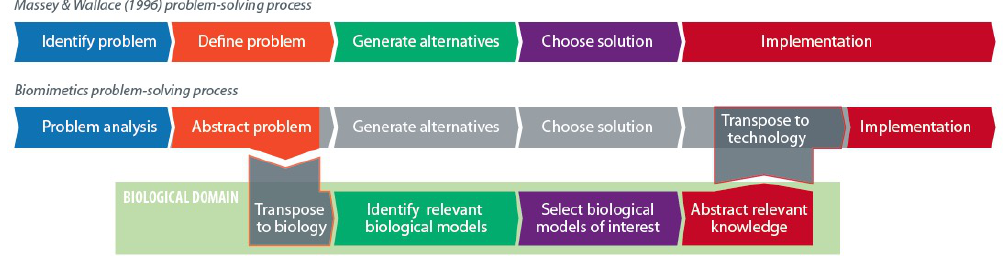
Figure 1. Overview of simplified, classical problem-solving ( top ) and generic biomimetics ( bottom ). In reality the designer has to know the external constraints in order to judge, e.g., whether transposing the selected biological information to technology is feasible and what the performance might be like [23]. Adapted from Fayemi et al.